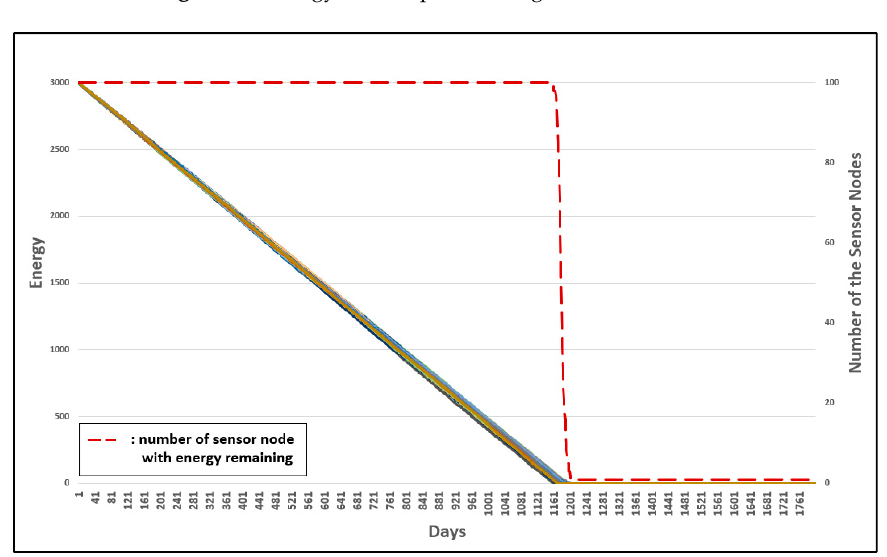
Figure 22. Energy consumption of original 3-D GM-MAC.